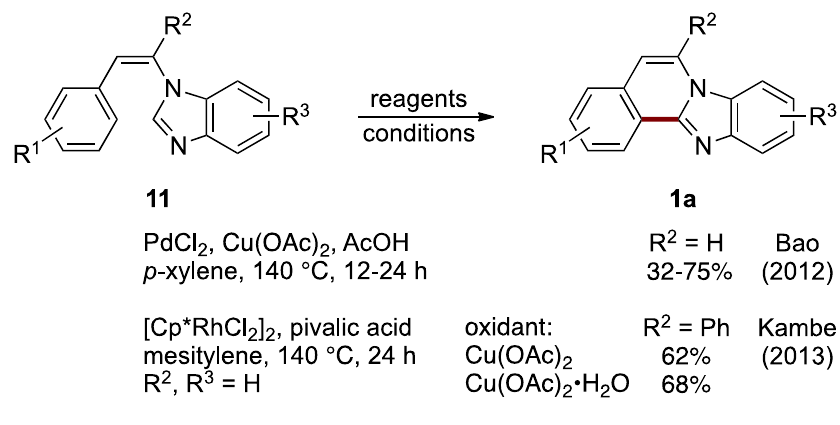
Figure 10. Palladium- and rhodium-catalyzed intramolecular cross-coupling of N -styrylbenzimidazoles 11 [22,23].